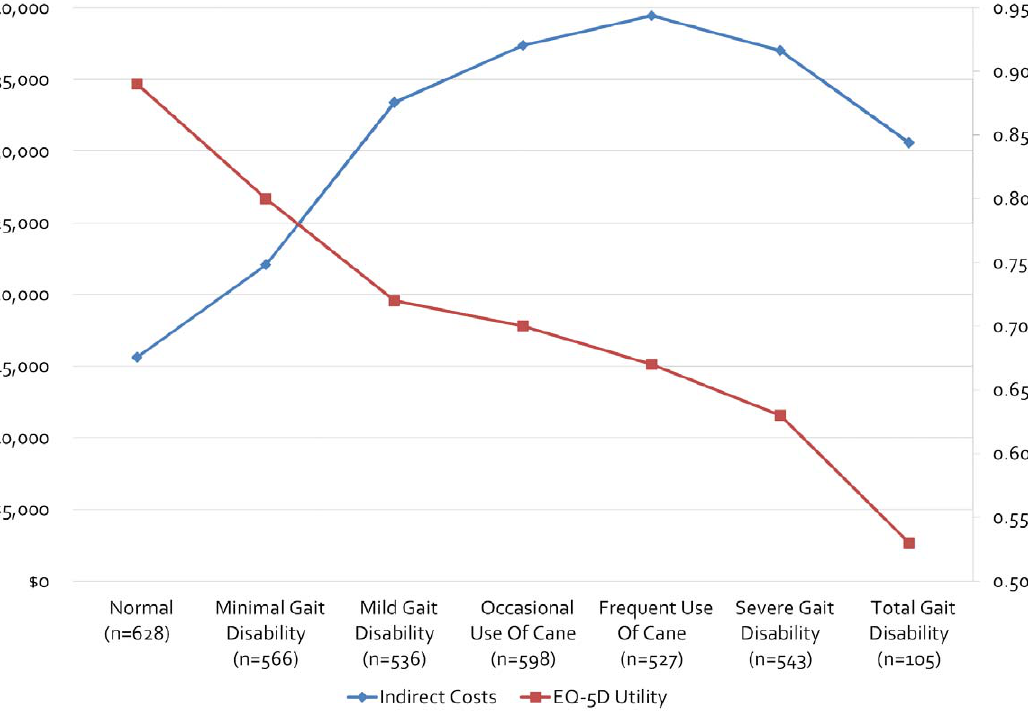
Figure 2. Indirect Costs and EQ-5D Health Utility Scores by NARCOMS Performance Scale Categories. Mobility Performance Scale= ‘‘In the past 4 weeks, compare your current condition to your mobility before you developed MS’’.